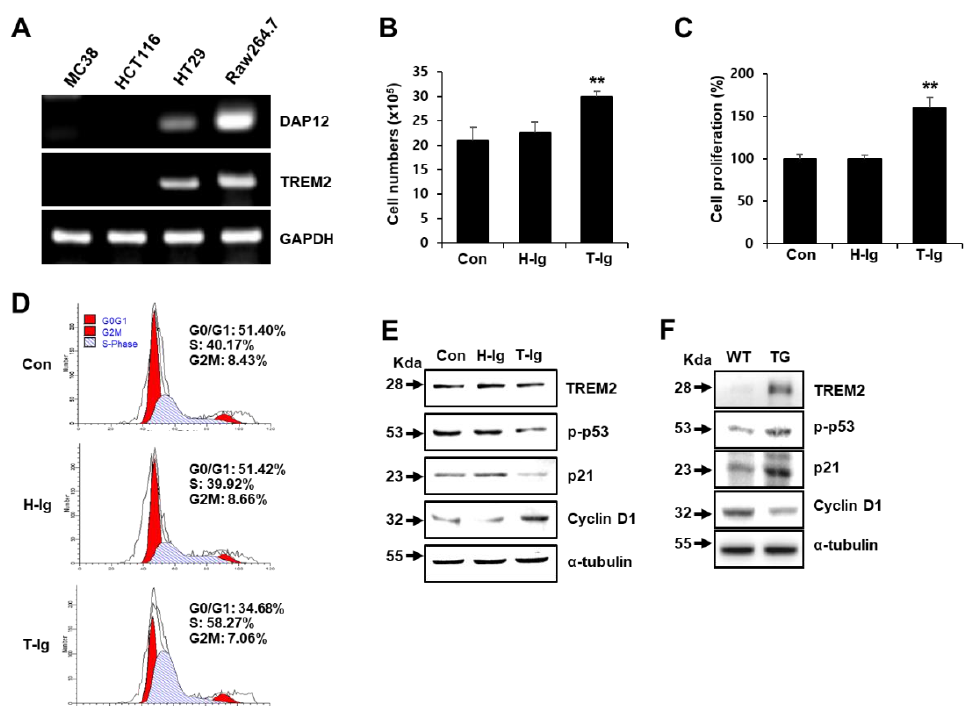
Figure 1. Blockade of triggering receptor expressed on myeloid cells (TREM)2 promotes the growth of HT29 colon cancer cells. ( A ) Using RT-PCR, mRNA expression levels of DNAX adaptor protein-12 (DAP12) and TREM2 were measured in MC38, HCT116, and HT29 colon cancer cell lines, and the Raw264.7 macrophage cell line was used as a positive control. ( B ) HT29 cells (1 × 10 6 cells) were plated in each well of six-well plates and treated with H-Ig or T-Ig (2 µ g / mL) for 48 h. Cell number was assessed by the trypan blue dye exclusion method, ( C ) and cell proliferation was analyzed by 3-(4,5-dimethylthiazol-2-yl)-5-(3-carboxymethoxyphenyl)-2-(4-sulphophenyl)-2H-tetrazolium) (MTS) assay. ( D ) Cell cycle analysis in HT29 cells treated with hIg or TREM2-Ig (2 µ g / mL) was performed by flow cytometry. ( E ) Cell cycle-related protein expression in HT29 cells ( F ) and in cells isolated from the colons of WT littermate and TREM2-TG mice was analyzed by Western blot. The data are representative of three independent experiments (** p < 0.01).